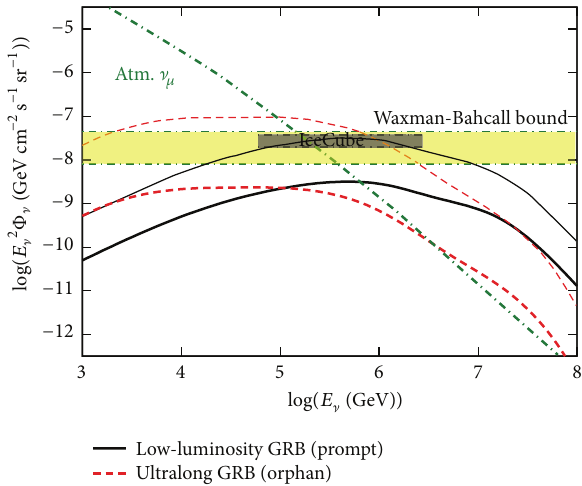
Low-luminosity GRB (prompt) Ultralong GRB Figure 3: The neutrino background from LL GRBs in the works of Murase et al. [141] and Murase and Ioka [51]. The optimistic case agrees with the observed neutrino intensity reported by Aartsen et al. [11].